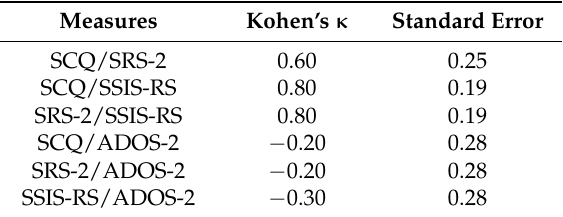
Table 3. Agreement among